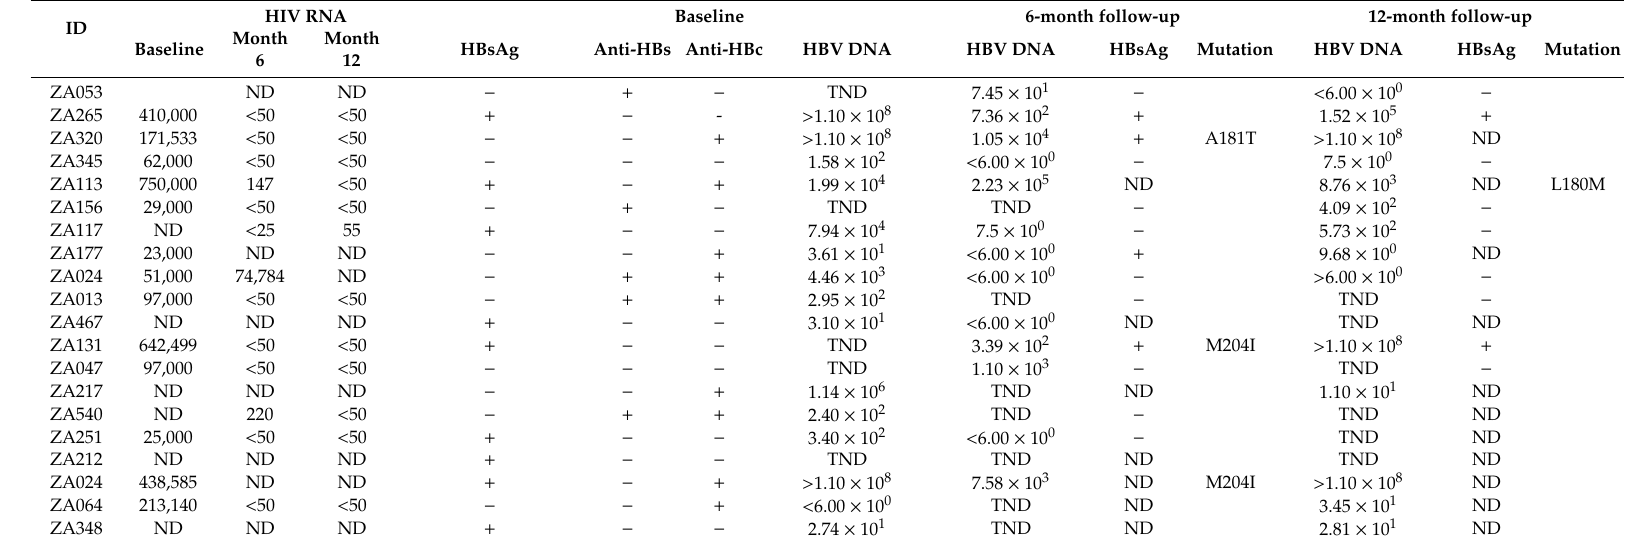
Table 3. HBV virologic response to lamivudine-based ART over 12 months of